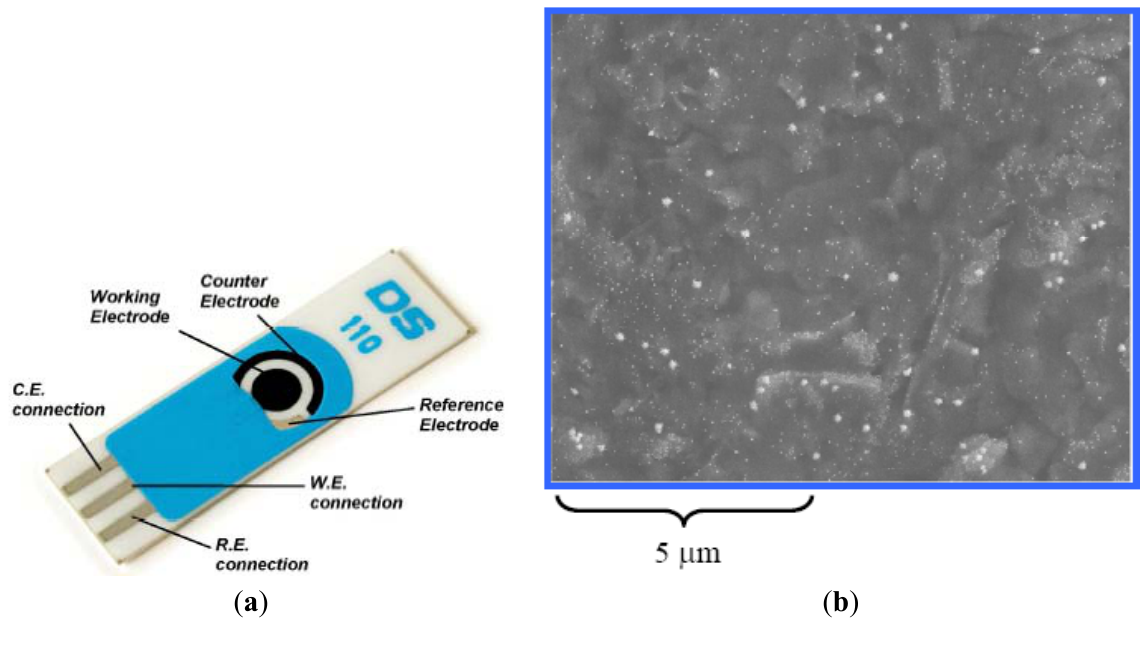
Figure 1. Images of the GNP-SPCE. ( a ) Photo of the electrode; ( b ) SEM image of working electrode. The figures originated from DropSens Inc. (Oviedo,